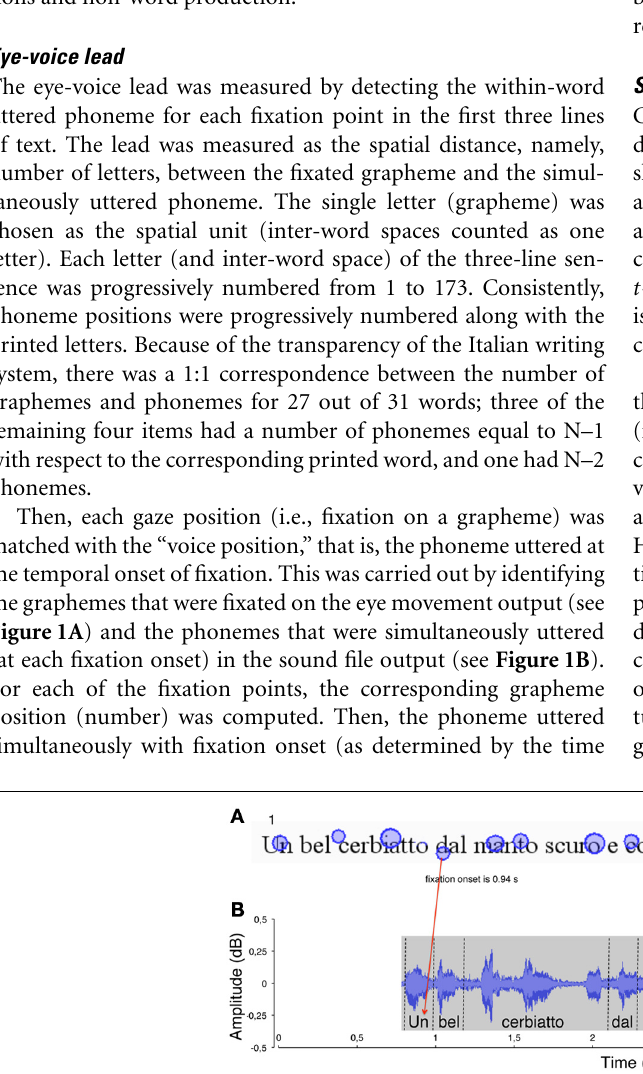
segments delimit the single word utterances, labeled along the timeline.